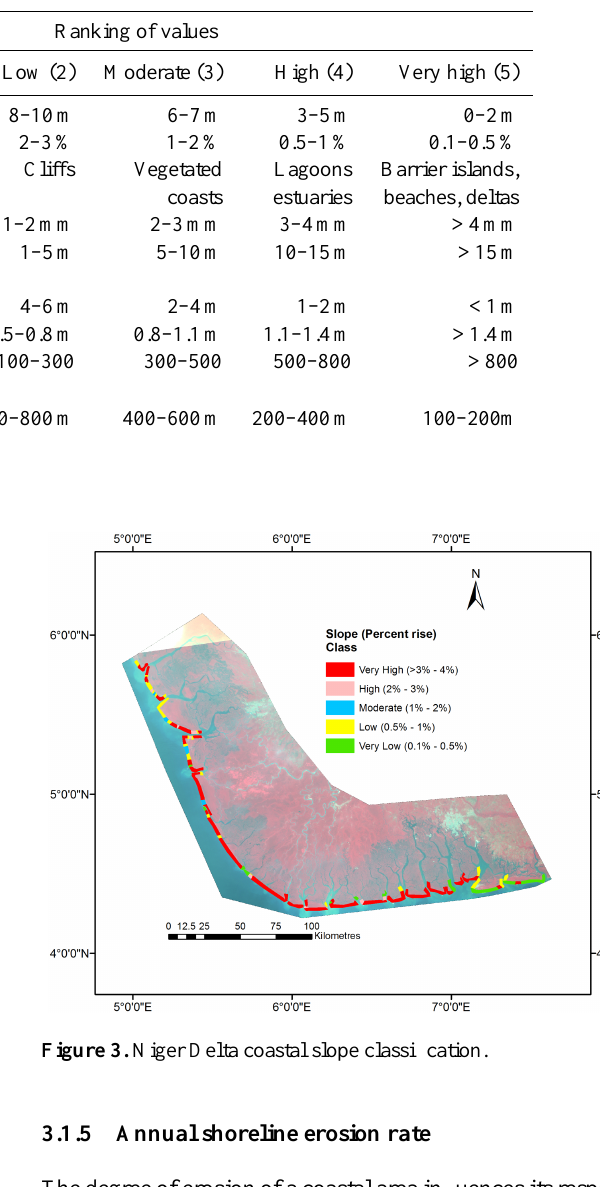
Table 2. Data range and ranking of the exposure CV SLR I variables.